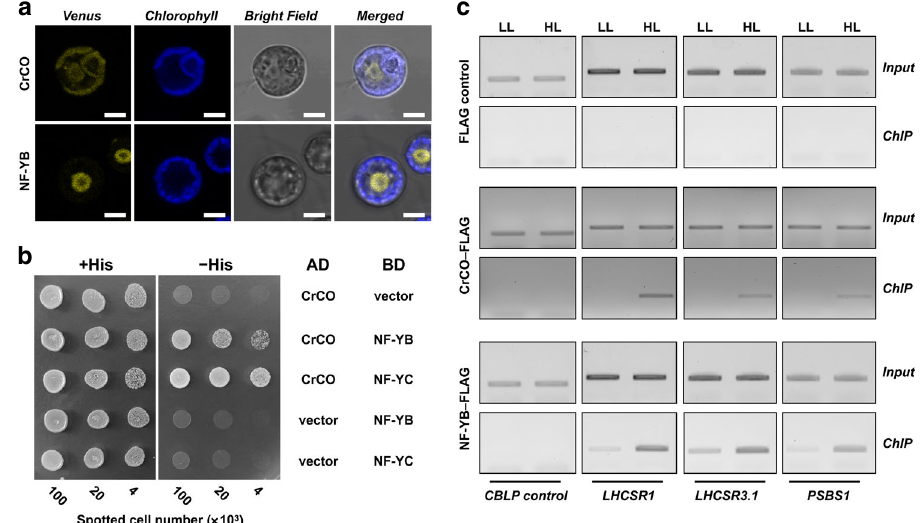
Fig. 2 CrCO interacts with NF-Y isoforms to form a transcriptional complex that associates with the promoter regions of the photoprotective genes. a Confocal live-cell imaging of the complemented strains, crco-2 / CrCO (labelled as CrCO) and nfyb-1 / NFYB (labelled as NF-YB), to visualize the localization of CrCO and NF-YB fused with Venus – 3xFLAG in C. reinhardtii cells. Scale bars, 5 µ m. b GAL4-based yeast two-hybrid (Y2H) assays. CrCO was fused to the GAL4-activation domain (AD – CrCO), whose ability to form heterodimers was tested by cotransformation of the GAL4-binding domain fused with NF – YB or NF-YC (BD – NF-YB or BD – NF-YC). Autoactivation was tested using empty vectors (AD or BD). The cells were plated on permissive ( + His) or selective ( − His) media and grown at 30 °C for 40 h after being spotted on the plates. c Chromatin immunoprecipitation (ChIP)-PCR assay of CrCO and NF-YB. Agarose gel electrophoresis showing the strength of the association of CrCO or NF-YB with the promoter regions of the photoprotective genes under different light treatments. ChIP was performed using 2 × 10 8 cells/mL of crco-2 / CrCO (labelled as CrCO) or nfyb-1 / NFYB (labelled as NF-YB) cells cross-linked with 0.35% (v/v) formaldehyde after a 1-h light